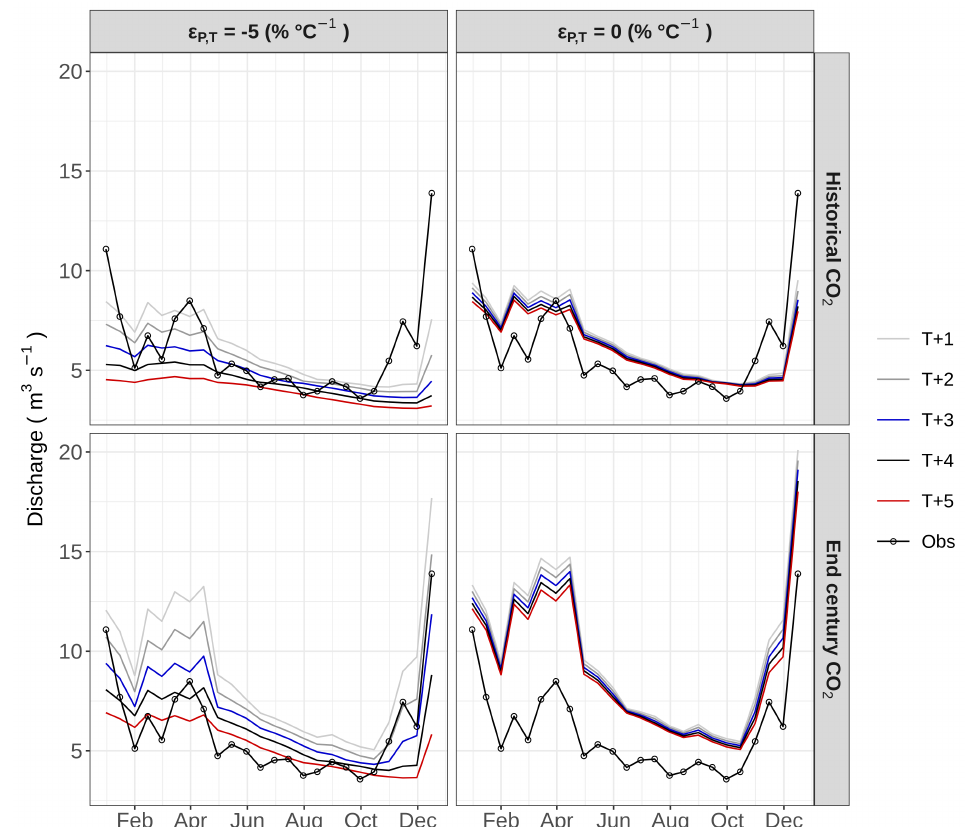
Figure 9. The 15-day mean of 2014 simulated discharge (in m 3 s − 1 ) with temperature increase (colors) and CO 2 concentration ( top and bottom panels) for prescribed changing precipitation of (cid:101) P , T = − 5% ◦ C − 1 ( left ) and (cid:101) P , T = 0% ◦ C − 1 ( right ), all for the alike RH case. Observed discharge in 2014 is shown as black line with